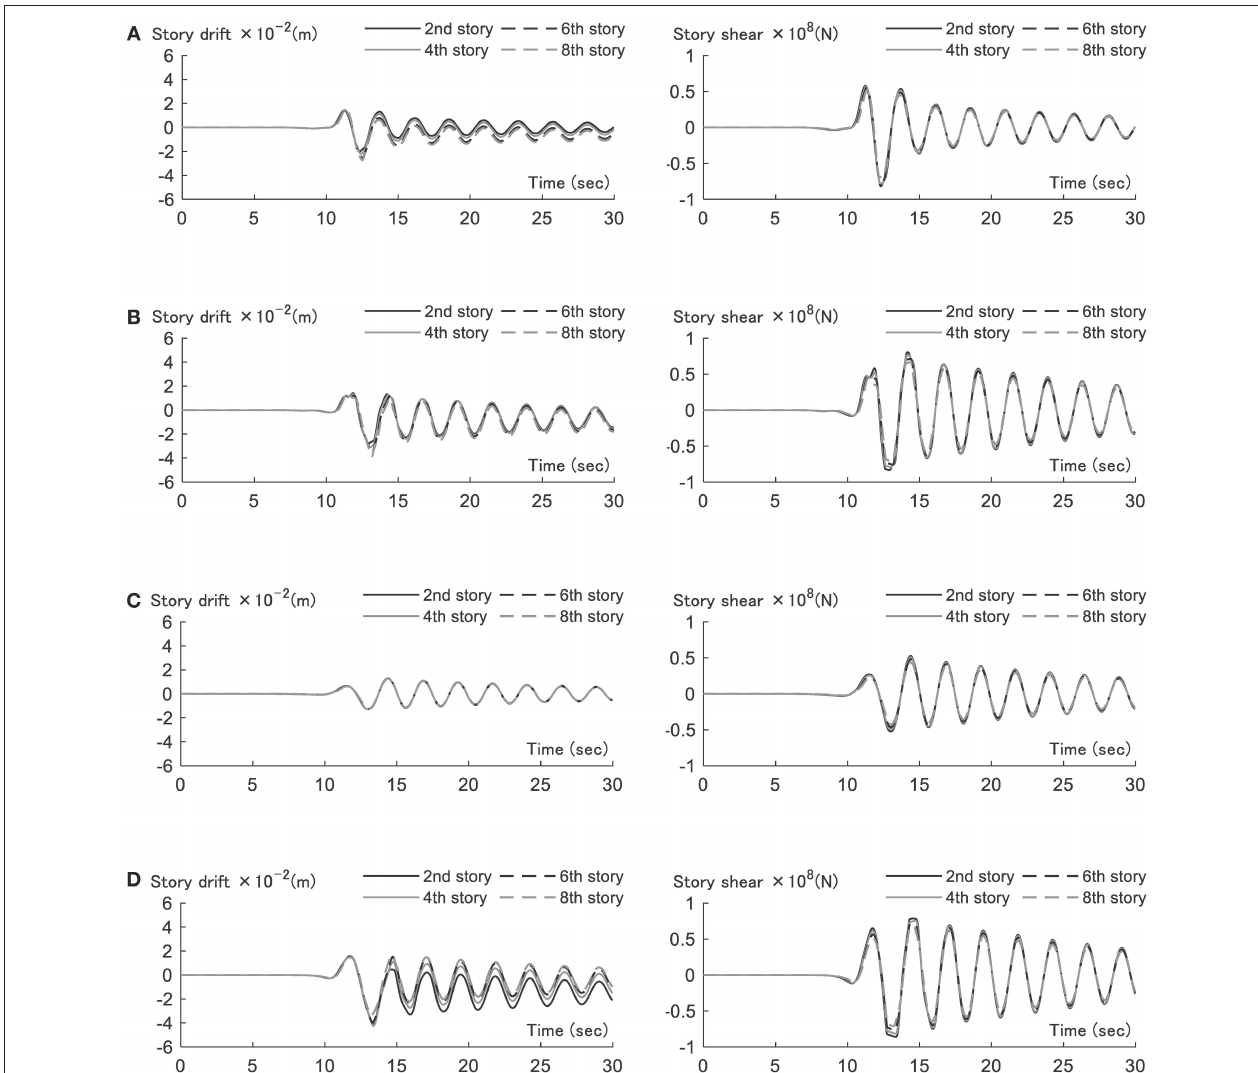
FIGURE 8 | Time history of inter-story drift and story shear for each fault model (component of transverse). (A) Recipe model 1. (B) Recipe model 2. (C) Nominal model. (D) Critical model.